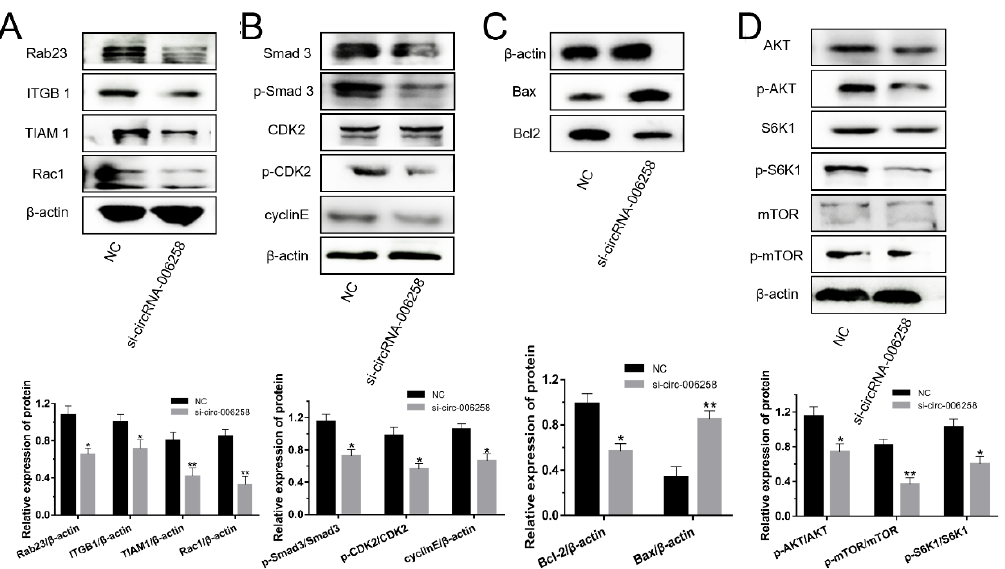
Figure 7. CircRNA-006258 promoted the milk synthesis of GMECs. ( A ) CircRNA-006258 influenced the protein expression of the Rab23/ITGB1/TIAM1/Rac1 pathway by WB. ( B ) Western blot analysis assessed the activation of circRNA-006258 on the TGF-β/Smad pathway in GMECs. ( C ) WB assay was conducted to investigate the protein expression of Bcl2 and Bax in the GMECs. ( D ) Investigating the effect of circRNA-006258 on the protein expression of the PI3K/AKT – mTOR pathway by WB assay in the GMECs. NC: negative control; si-circRNA-006258: small interfering RNA. ** means significant difference ( p < 0.01), * means significant difference ( p < 0.05).